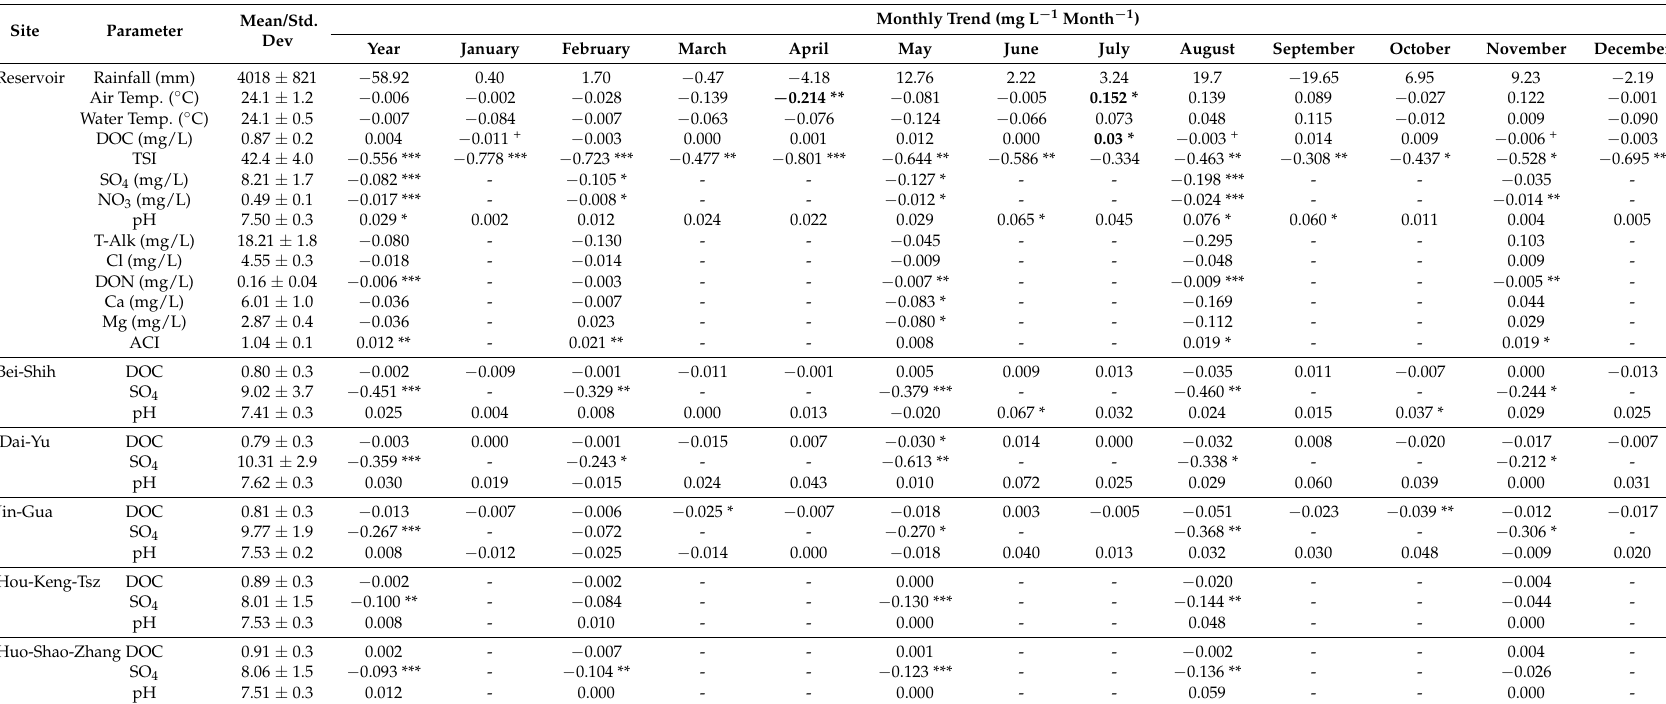
Table 2. Annual and monthly trends for climate, DOC and chemistry parameters in Fei-Tsui Reservoir and tributaries from 2000 to 2015.